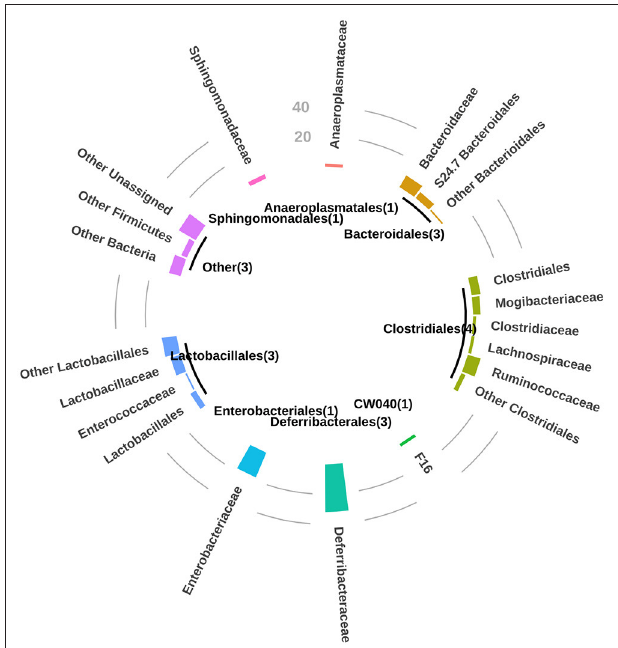
FIGURE 6 | For P -value < 0.01, bar circle graph showing the number of natural anti-glycan antibodies structures associated with the bacterial taxa at a taxonomic level of order and family. Between brackets, in the central circle are the numbers of mice related to these